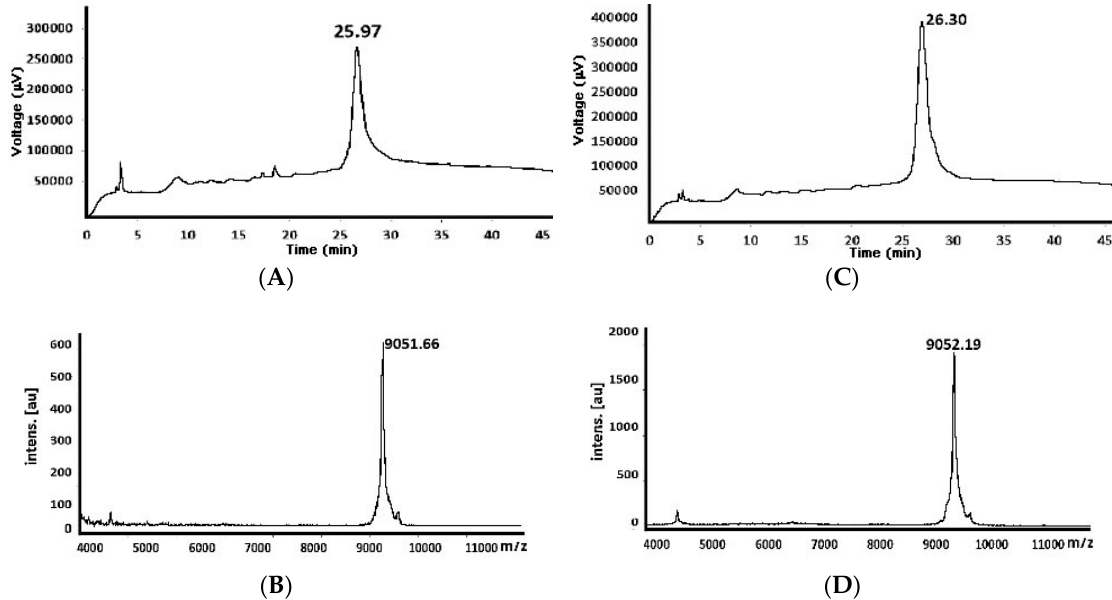
Figure 2. Chromatographic profiles and mass spectrum of the purified peptide’s 82nd residue (MW theoretical 9051.42 Da) obtained by standard ( A ) and ( B ) (Chromatogram and mass spectra, respectively) and MV-assisted reaction conditions ( C ) and ( D ) Chromatogram and mass spectra, respectively).